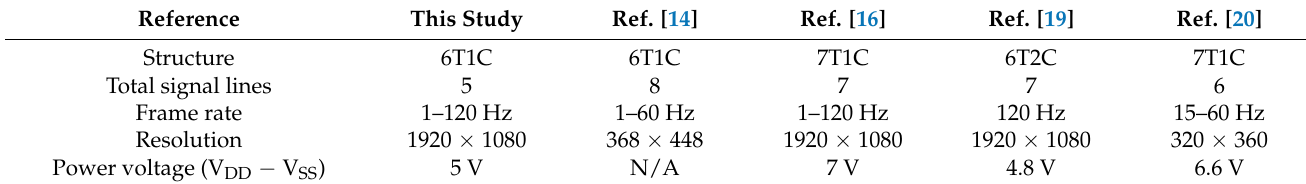
Table 2. Comparison between proposed and previously published pixel circuits.